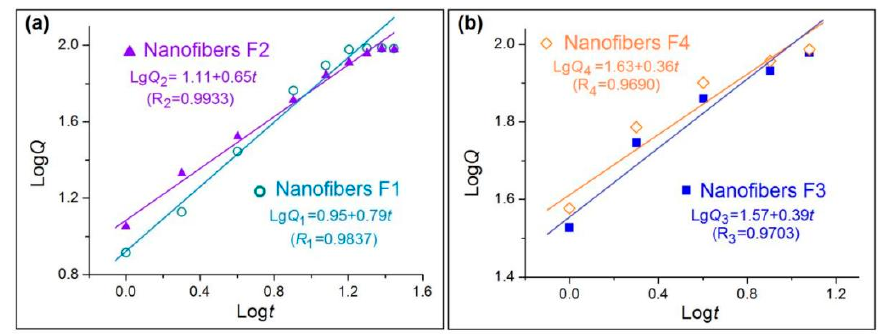
Figure 9. Drug release mechanisms from nanofibers F1 and F2 ( a ) and F3 and F4 ( b